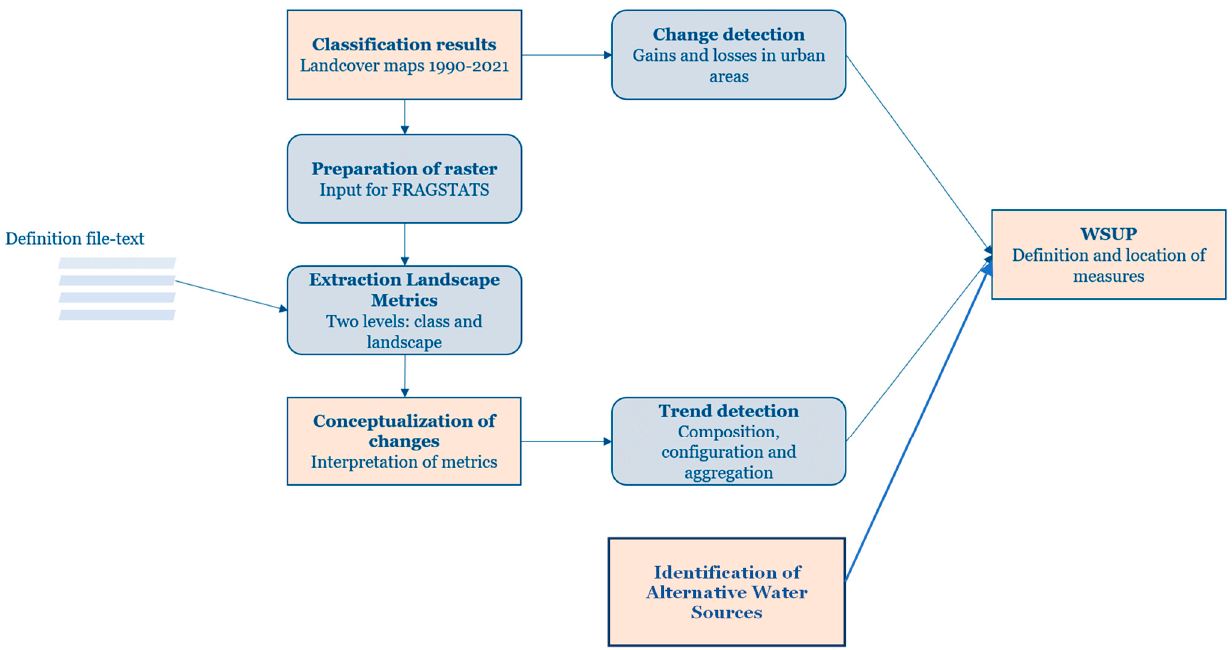
Figure 2. Methodology for the integration of a water-sensitive urban plan for Lima Metropolitan Area .